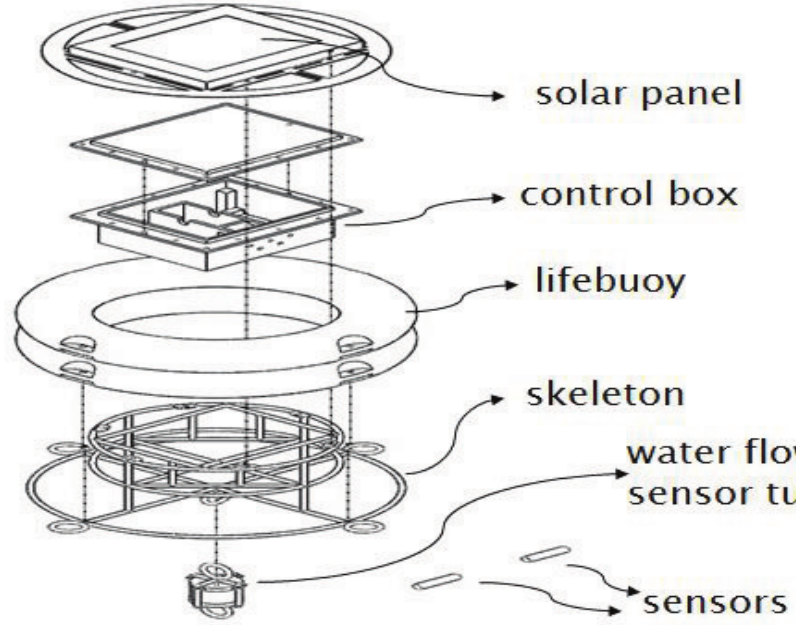
Figure 1. Architecture of the proposed offshore